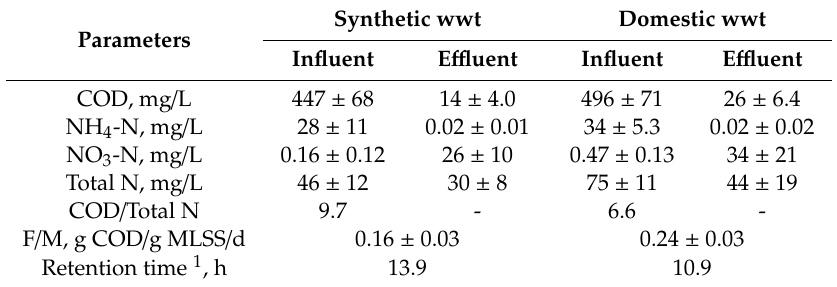
Table 2. Physicochemical characteristics of influent and e ffl uent for synthetic and domestic wastewater. wastewater. Parameters